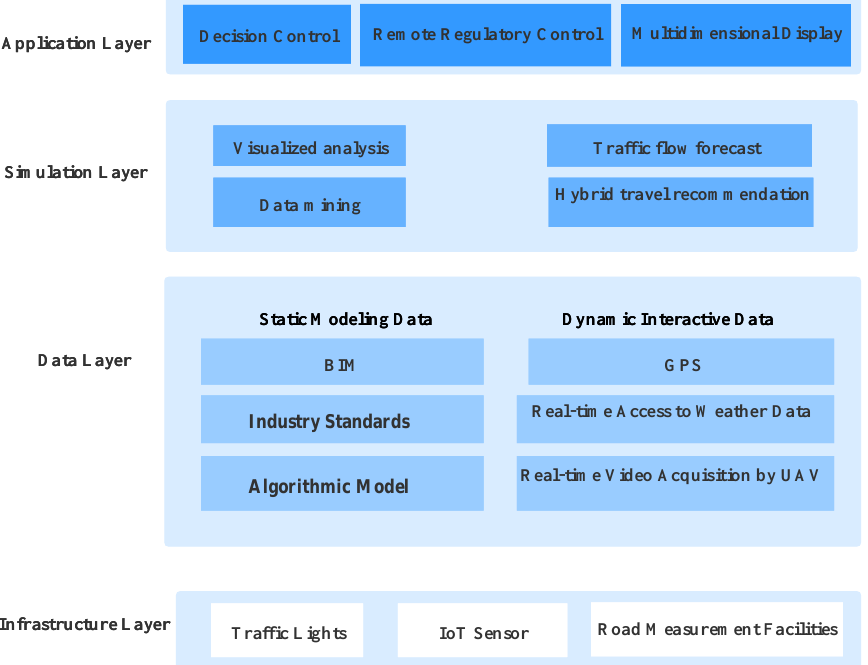
Figure 2. Digital twin technology based on ITS system. The infrastructure layer includes physical entities such as signal lights, sensors, and road test facilities. The data layer is divided into static modelling data and dynamic interactive data, which belong to physical entity data; the simulation layer is based on the virtualization of physical entity data, mainly including visualization analysis, traffic flow prediction, data mining, mixed travel recommendation and so on; application layer is the application convenience provided by virtual entities for users, including decision control, remote control, multi-dimensional display and so